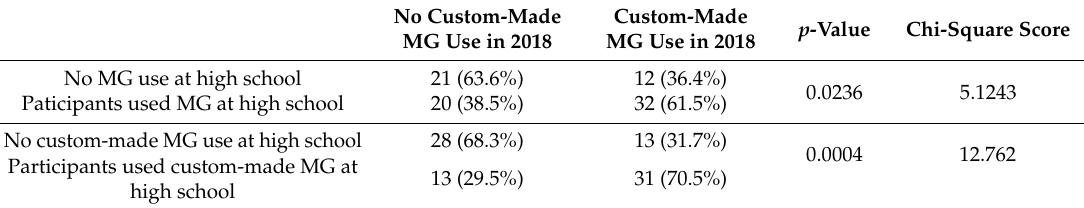
Table 6. Relationship between MG usage in high school and custom-made MG wearing rates.